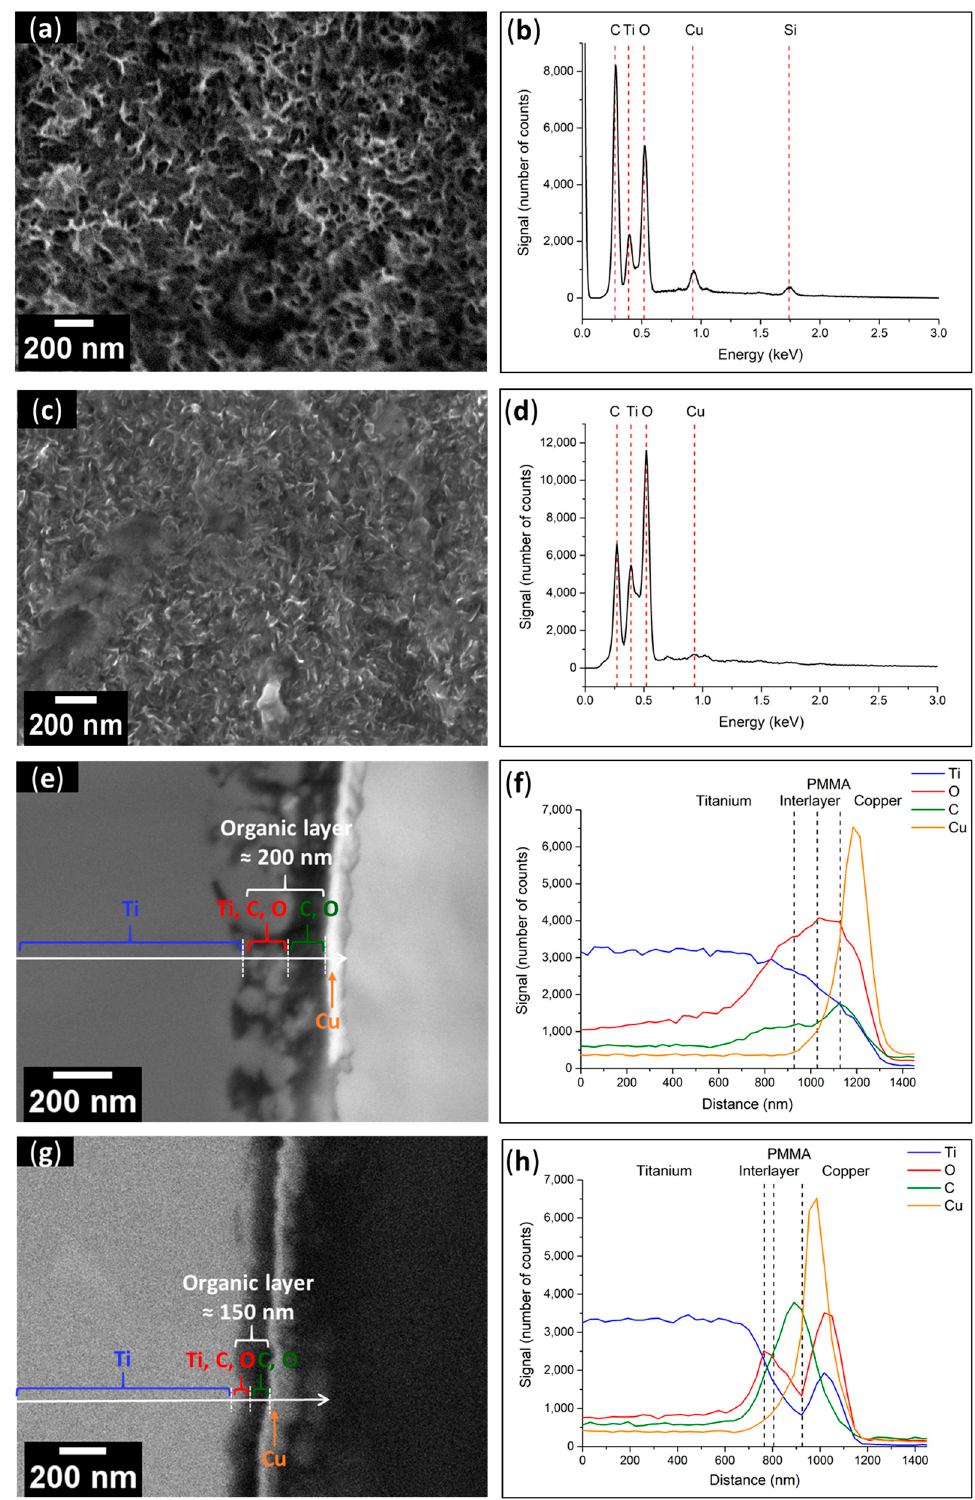
Figure 10. ( a ) SEM top-view image of Ti–PMMA and ( b ) EDX spectrum of Ti–PMMA surface before UV exposure; ( c ) SEM top-view image and ( d ) EDX spectrum of Ti-PMMA surface after UV exposure; ( e ) SEM cross-section and ( f ) linear analysis of Ti–PMMA interface before UV exposure; ( g ) SEM cross-section and ( h ) linear analysis of Ti–PMMA interface after UV exposure. These findings were supported by the cross-sectional views and linear EDX spectros- copy investigations, which showed similar results before and after UV light exposure.